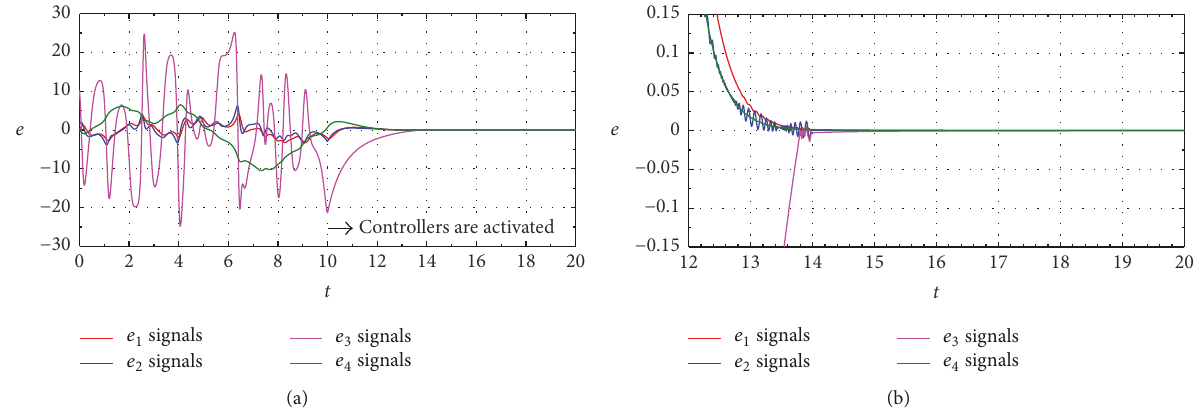
Figure 7: Synchronization errors with the proposed switching controllers are activated: (a) 𝑡 ≤ 20 ; (b) 𝑡 ≥ 12 , 𝑡 ≤ 20